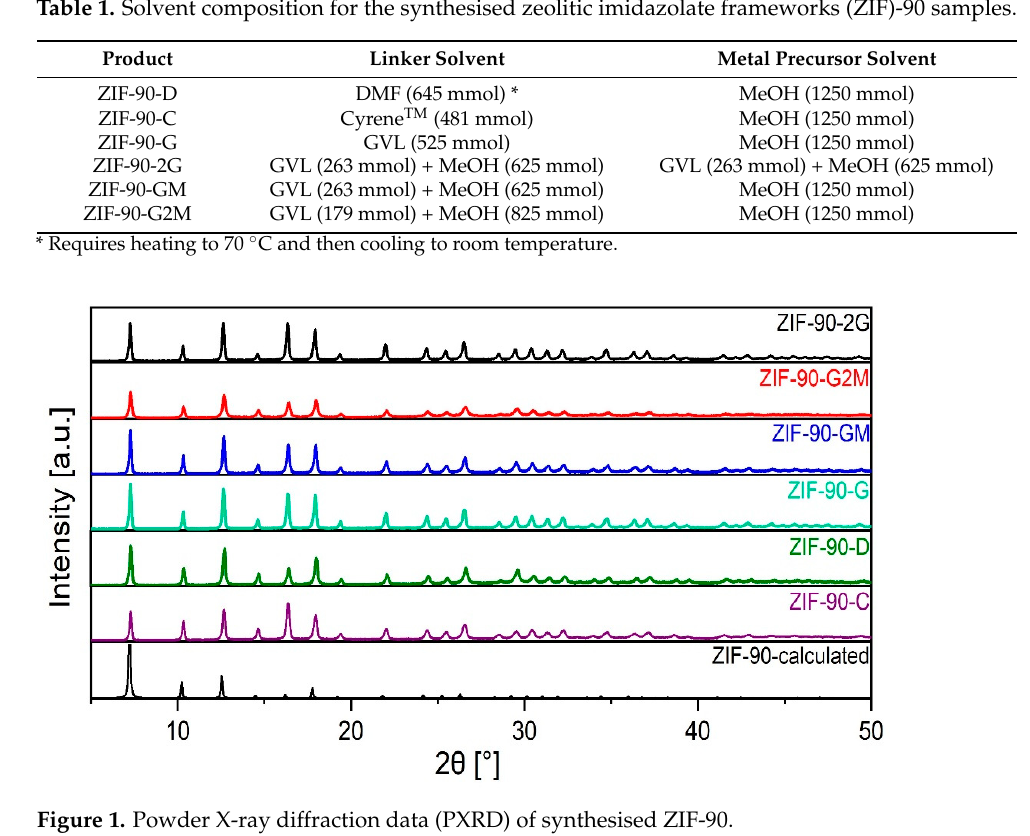
Table 1. Solvent composition for the synthesised zeolitic imidazolate frameworks (ZIF)-90 sam- ples.